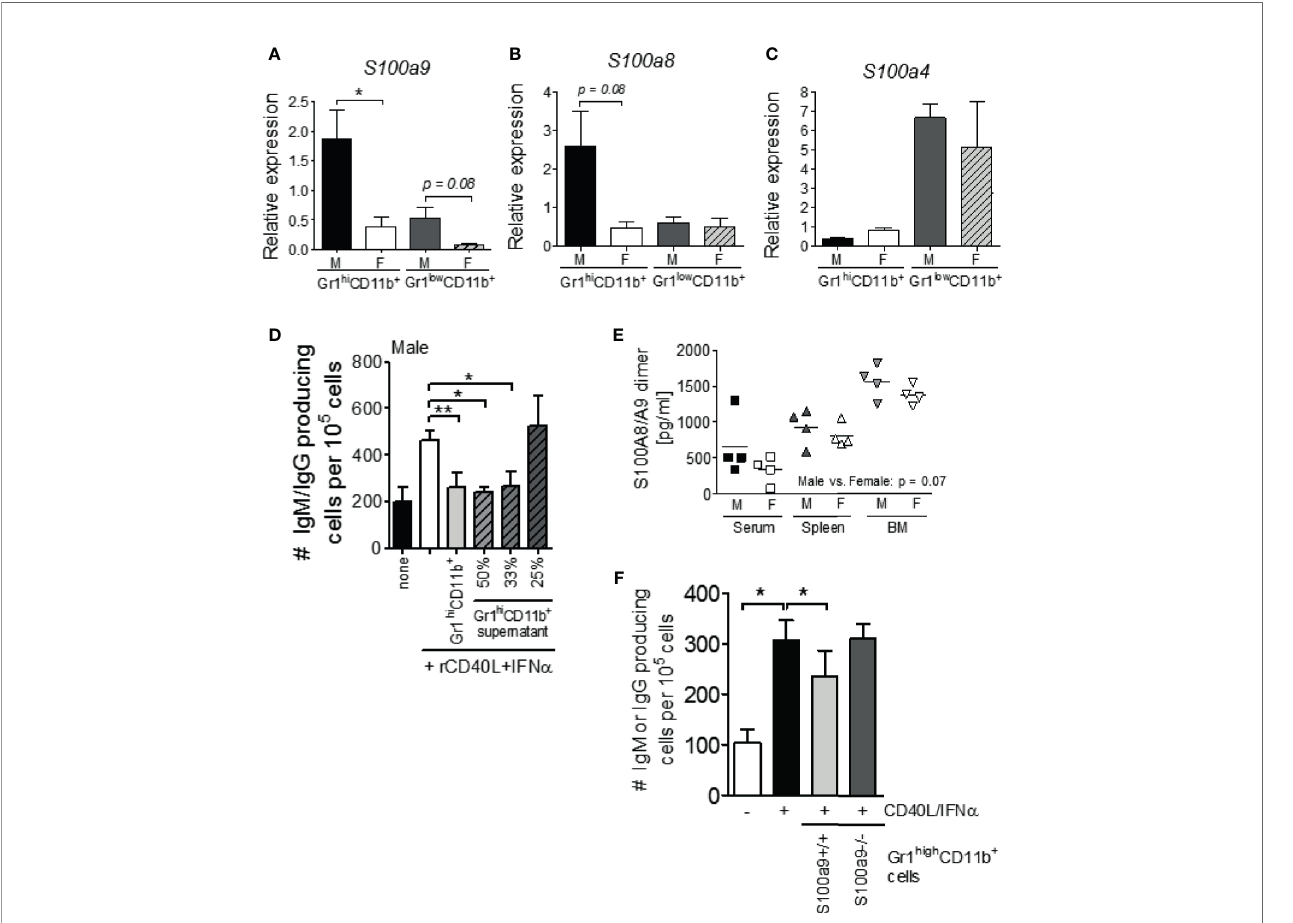
FIGURE 1 | S100a9 expression is elevated within Gr1 high CD11b + cells of male lupus-prone mice and regulates B cell differentiation in vitro and antibody production in vivo . Gr1 high CD11b + and Gr1 low CD11b + cells were isolated from 9 week old male and female NZBWF1 lupus-prone mice by fl ow cytometry and levels of S100a9 (A) , S100a8 (B) , and S100a4 (C) mRNA were determined by RT-PCR analysis ( n = 4). Graphs show mean +/- SEM. (D) Supernatants from overnight cultured Gr1 high CD11b + cells from 4 wk old NZBWF1 male mice suppress IFN a /CD40L-driven B cell differentiation. Shown is the average (± SEM) of 4